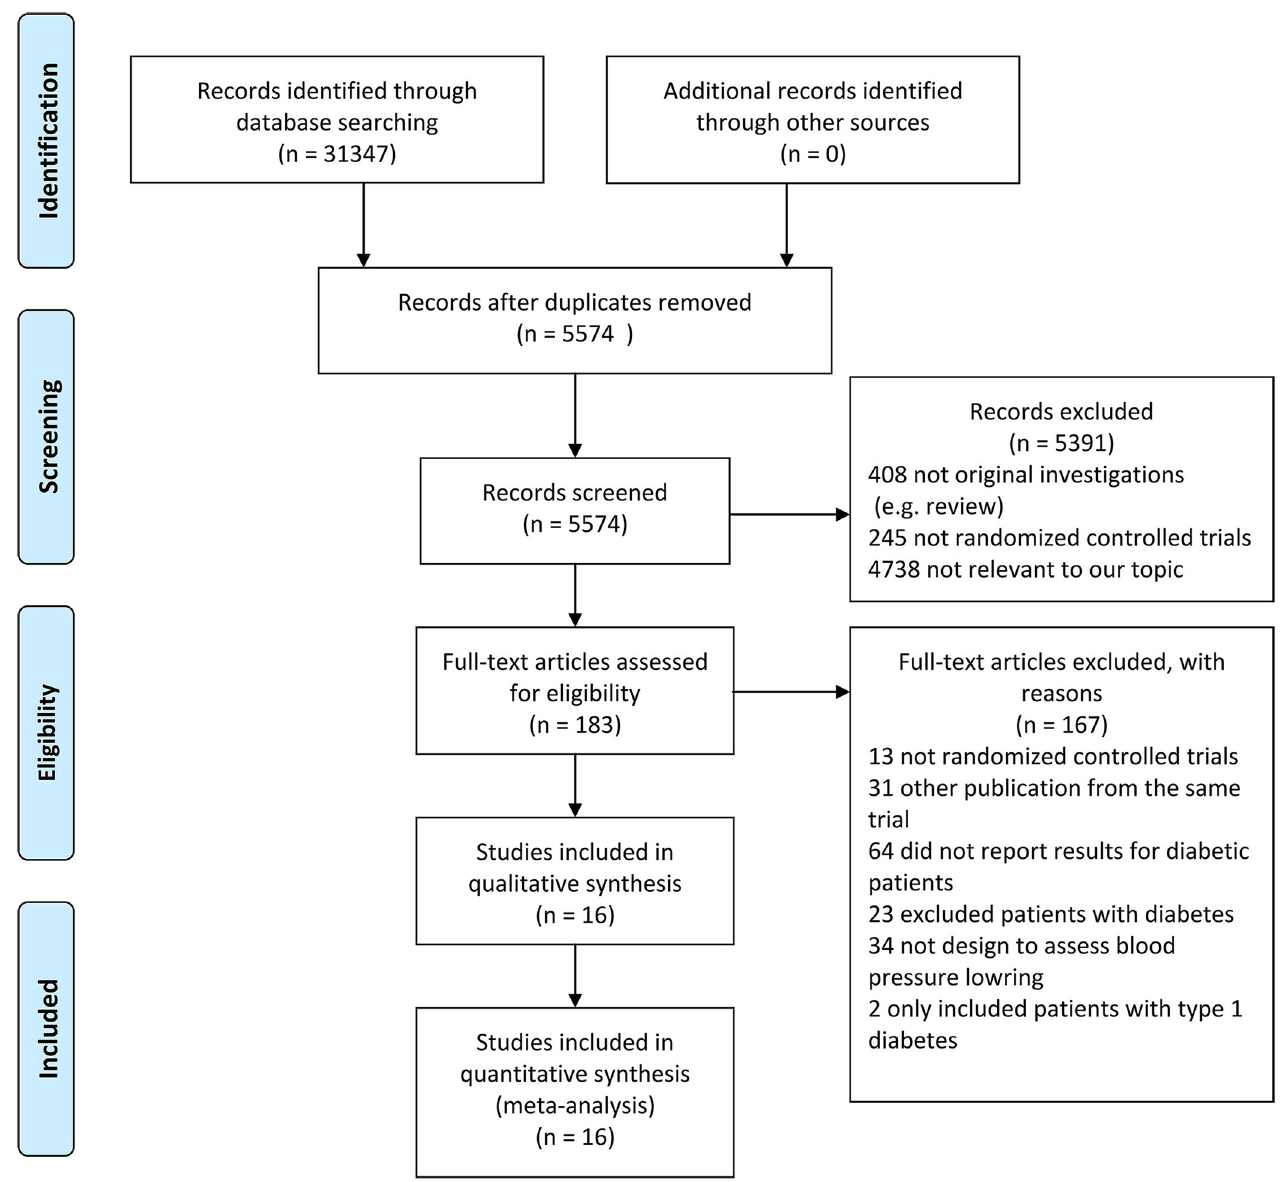
Fig 1. Flowchart of trial identification for